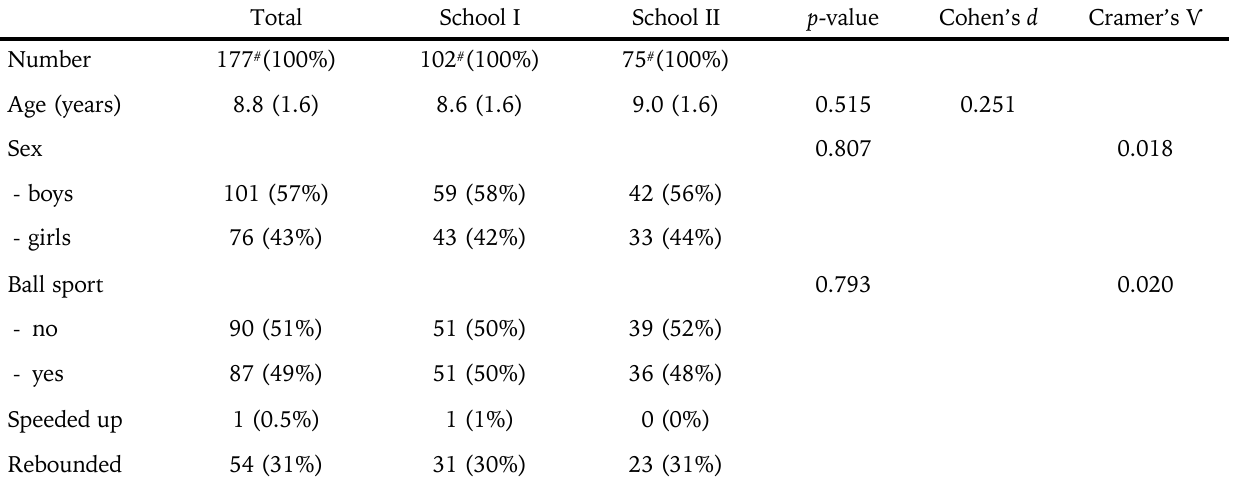
Sample characteristics